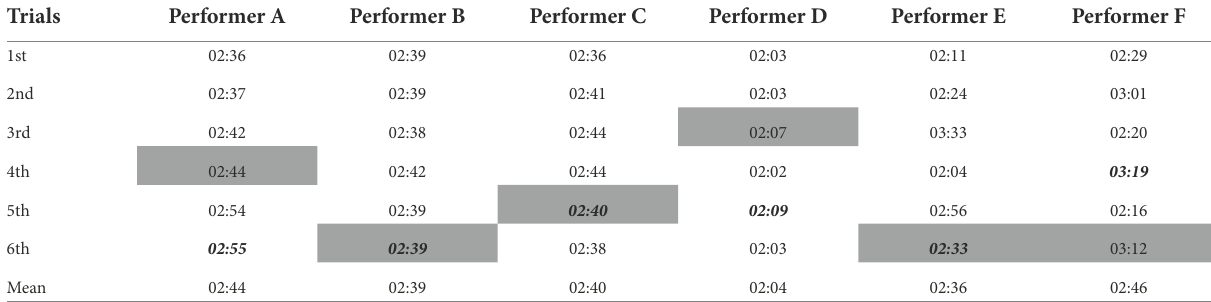
TABLE 2 The length of each